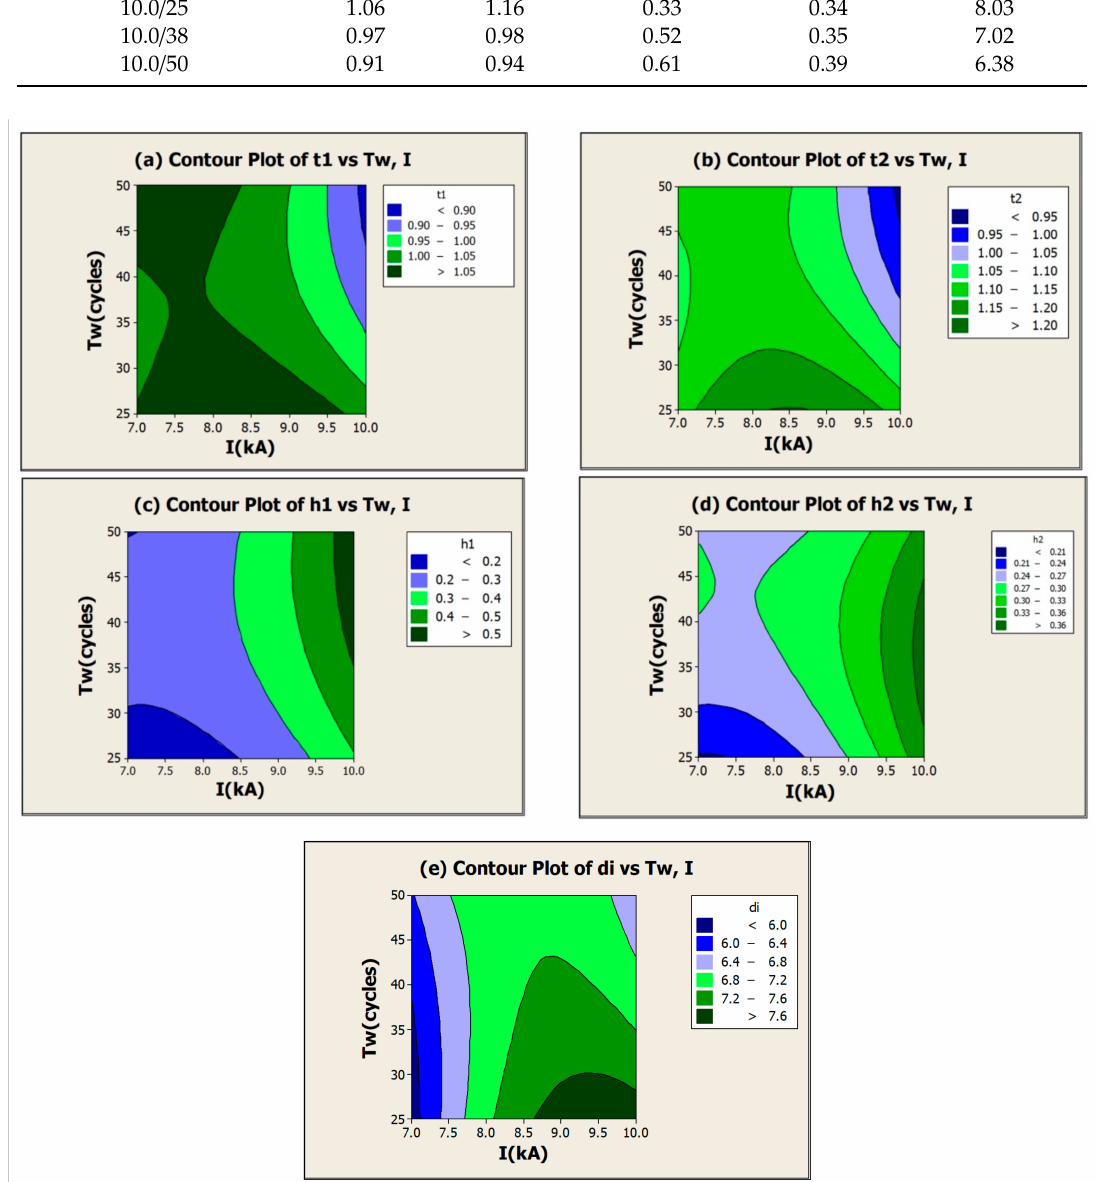
Figure 5. E ff ect of weld current and welding time on weldment quality metrics: ( a ) t1; ( b ) t2; ( c ) h1; ( d ) h2; ( e )